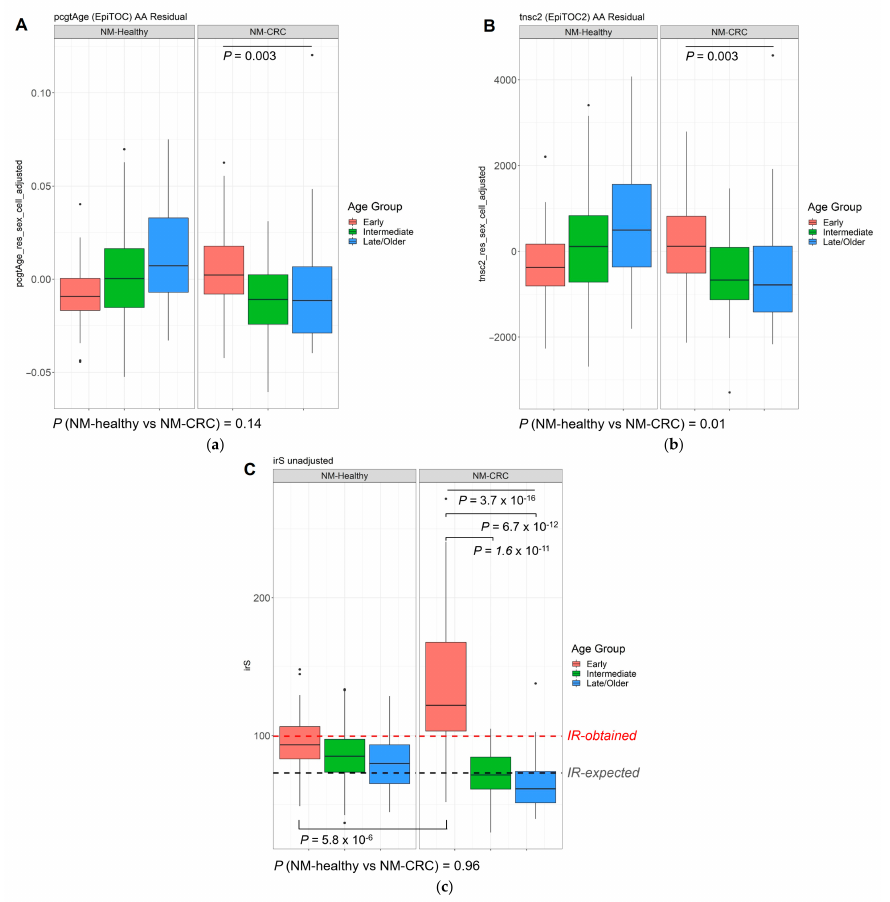
Figure 5. Boxplots showing the distributions of AA measured by epiTOC ( a ), epiTOC2 ( b ), and irS ( c ), in NMs from people without (“NM-Healthy”) and people with CRC (“NM-CRC”). AA was measured by calculating residuals from a linear regression analysis of DNAm age on chronological age for each individual. p -values between two tissue types (NM-Healthy vs. NM-CRC) were obtained by performing Wilcox tests, whereas p -values between three age groups were obtained from Kruskal- Willis tests. In ( c ), the red horizontal line denotes previously computed average irS (IR) in normal colonic mucosa [20], and the black horizontal line denotes an expected experimentally derived stem-cell division rate for colorectal tissue